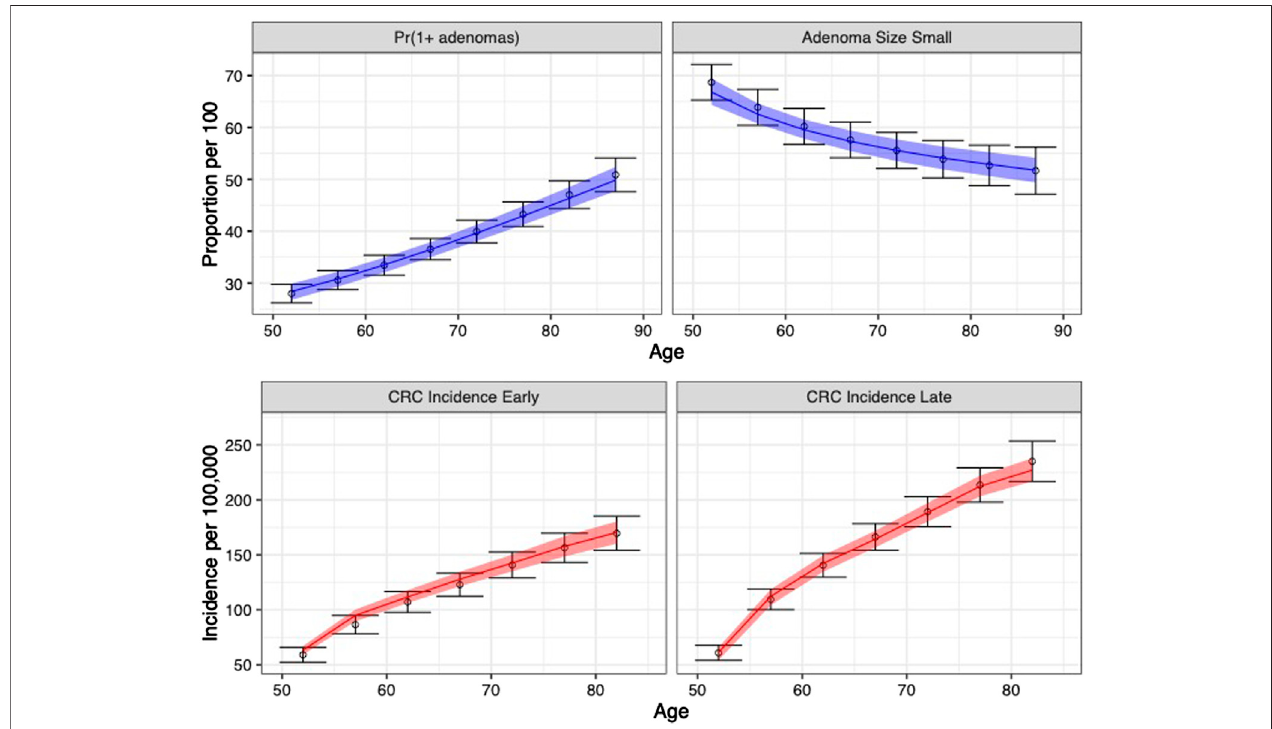
FIGURE4 | Comparison between posterior model-predictedoutputsand calibrationtargets. Calibration targets withtheir 95% CIareshown inblack.The shaded areashowsthe95%posteriormodel-predictiveintervaloftheoutcomesandcoloredlinesshowstheposteriormodel-predictedmeanbasedon5,000simulationsusing samples from the posterior distribution. Upper panel refers to adenoma-related targets and lower panel refers to CRC incidence targets by stage.